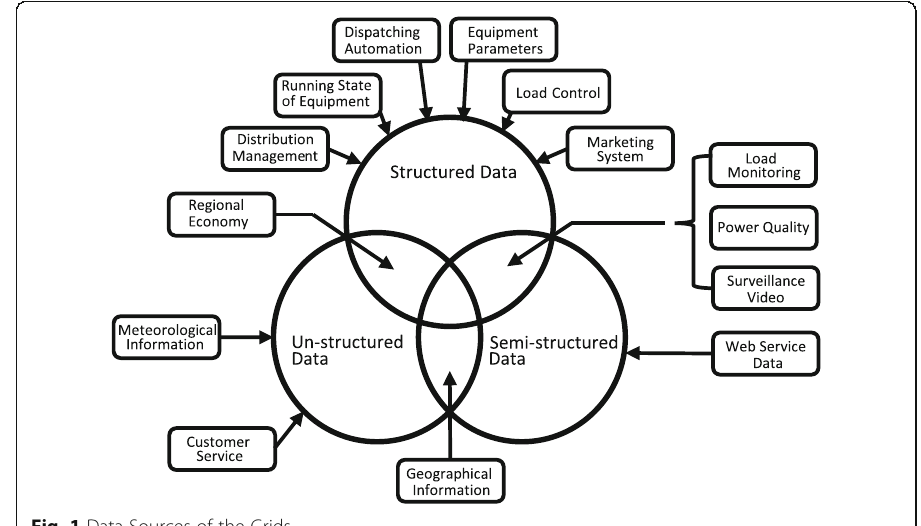
Fig. 1 Data Sources of the